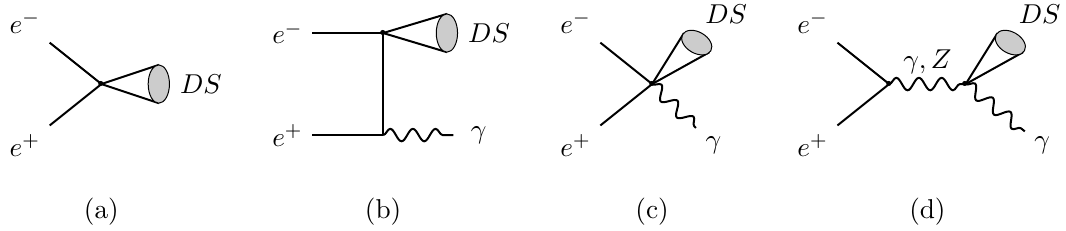
Figure 13 . Feynman diagrams for o-Ps → DS (diagram (a)), mediated by the D = 6 portal ¯ eγ µ e , and for o-Ps → γ + DS , mediated by the D = 8 portals T DS J DS µ its crossed and diagram (c)) and T DS